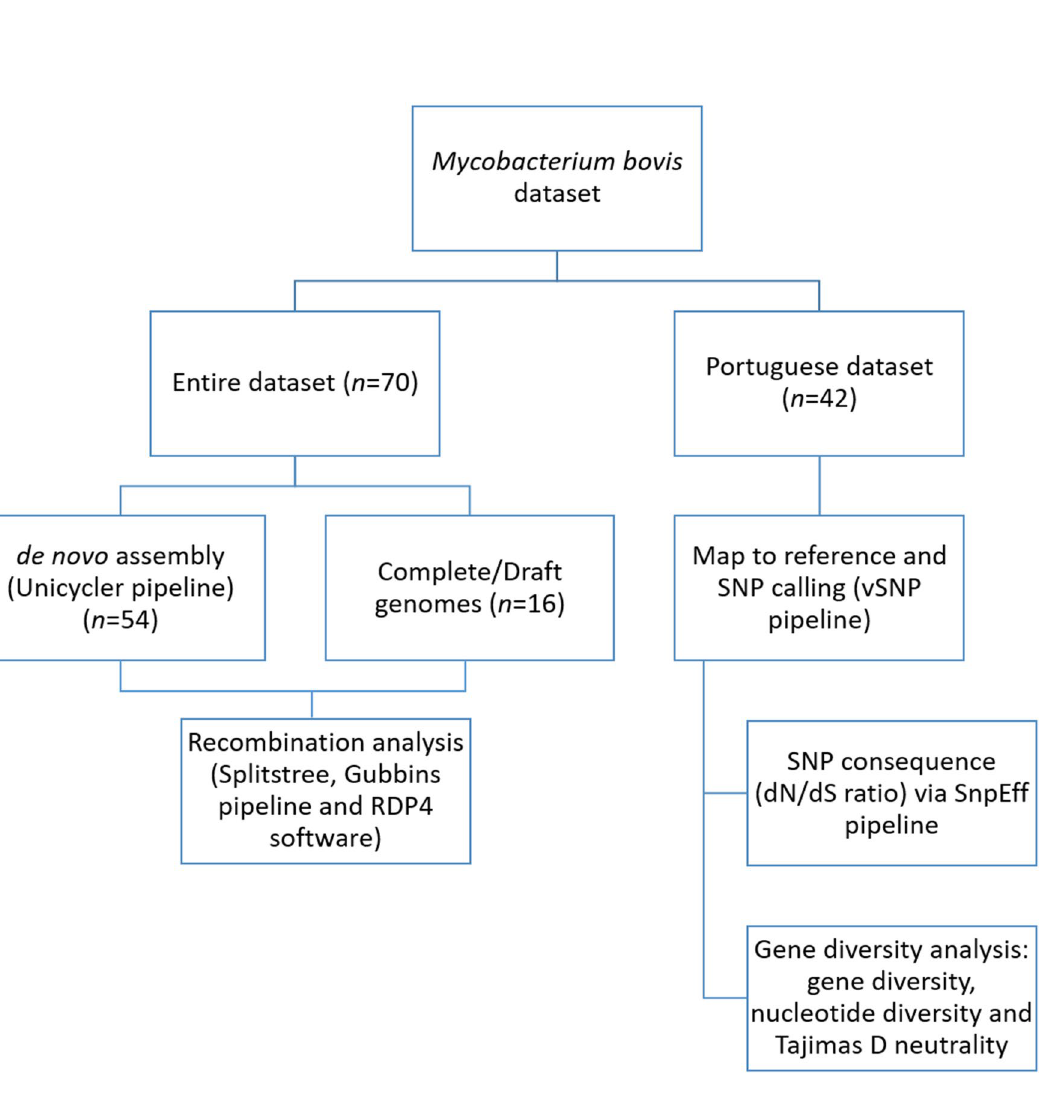
Figure 1. Bioinformatics workflow followed in this